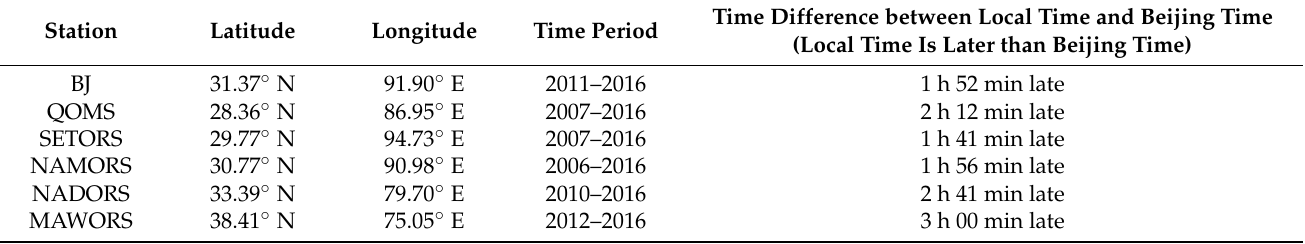
Figure 1. Geographical distributions of the six meteorological stations over the TP and the time series of the annual mean SH (units: W m − 2 ) at these six stations during the period 2006–2016. The blue dotted lines indicate the decreasing and increasing trends at MAWORS and SETORS, respectively. Table 1. List of the stations in the hourly integrated observational dataset, including the station names, latitudes, longitudes, time periods, and the time difference between local time and Beijing time.